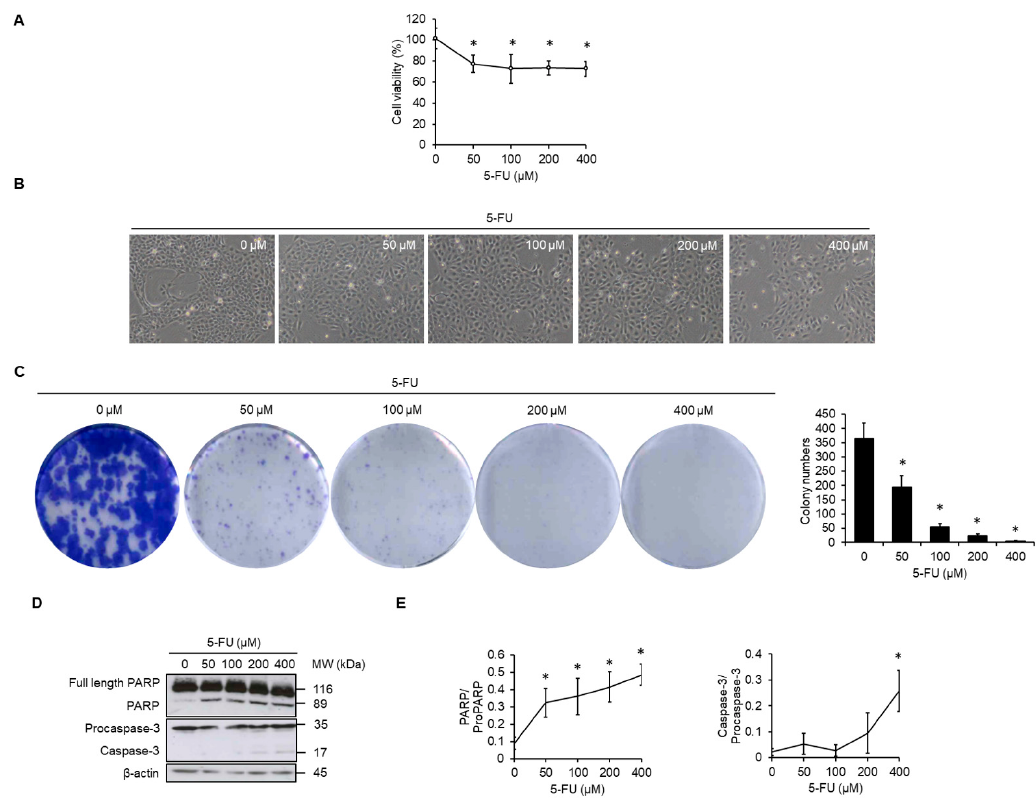
Figure 1. 5-FU inhibits cell proliferation and causes apoptosis in SCC4 cells. The cells were treated with increasing concentrations of 5-FU (50, 100, 200, and 400 µM) for 24 h. ( A ) The cell viability was measured using MTS/PMS assay. ( B ) The cell density was observed under a light microscope (10×). ( C ) Representative images of colony formation assay and their quantitative analysis. The ( D ) West- ern blot analysis showing the protein expression of PARP, cleaved PARP, pro-caspase-3, and caspase-3. The ( E ) relative densitometric graphs showing PARP and caspase-3 cleavage. * p < 0.05, as compared to the control. All experiments were independently performed at least three times.